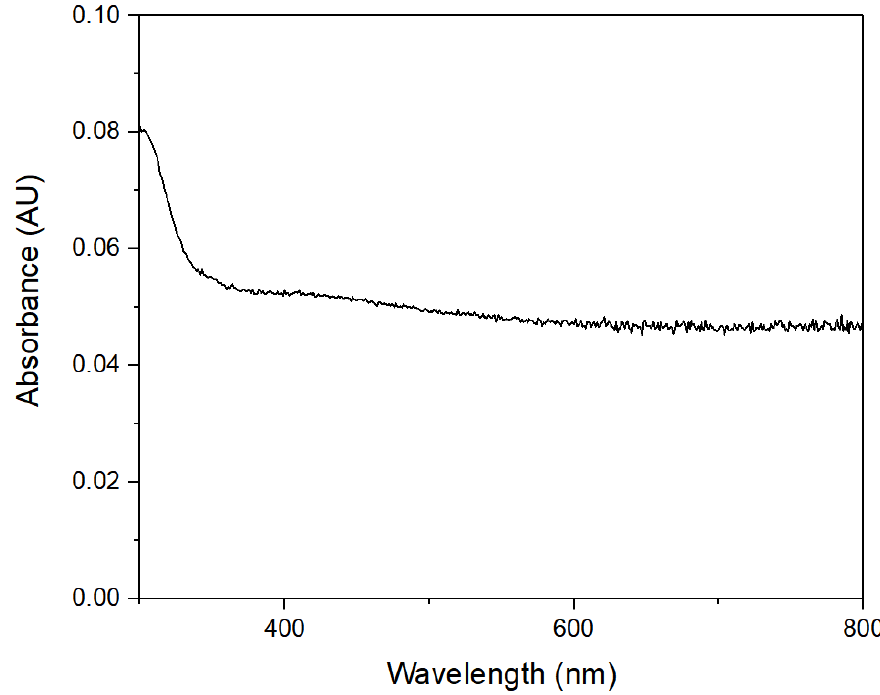
Figure 1. UV-vis absorbance spectrum of the control experiment: silver ions in deionised water.